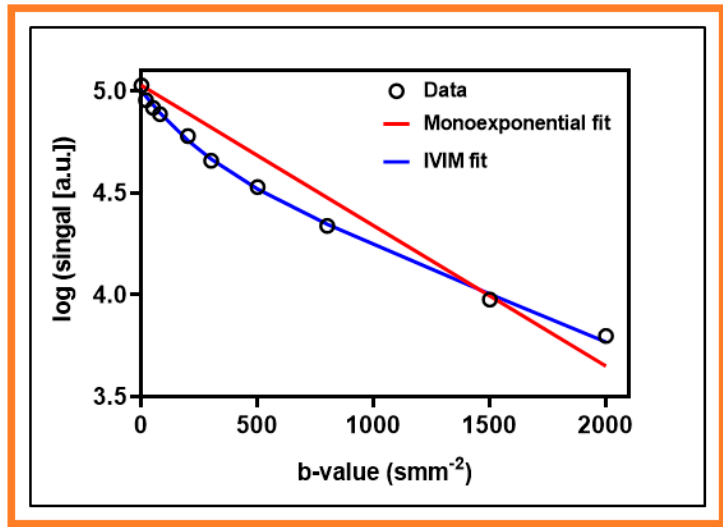
Figure 1. Representative mean semilogarithmic signal intensity decay curve as a function of the multiple b-value (black circle). The data were fitted with the monoexponential model (solid red line) and intravoxel incoherent motion (IVIM) model (solid blue line).